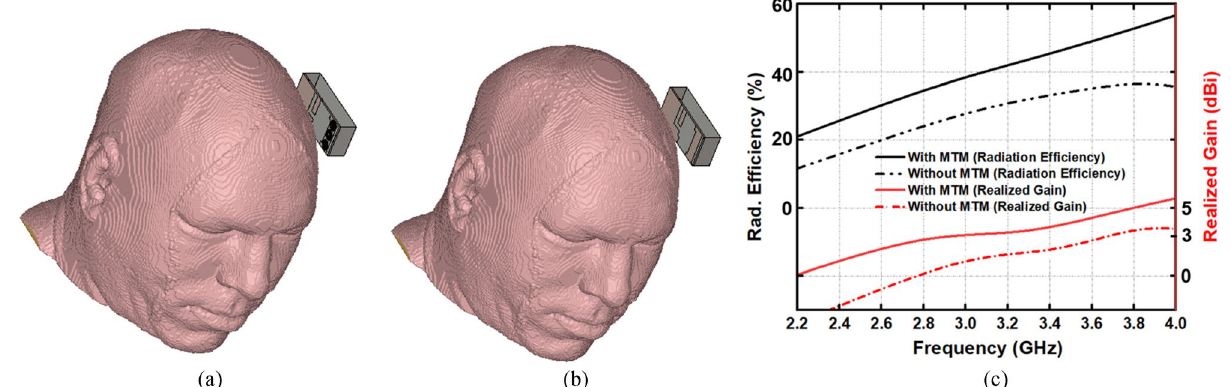
Radiation efficiency